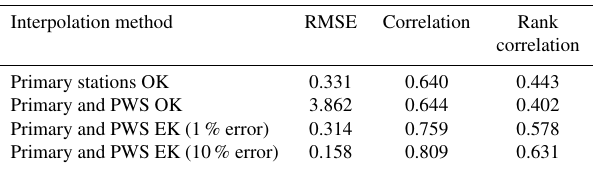
Table 6. RMSE (in millimetres) and correlations for all stations for all time steps (5136) between April and October 2019 for OK and KU, with different error assumptions for 1h aggregation.